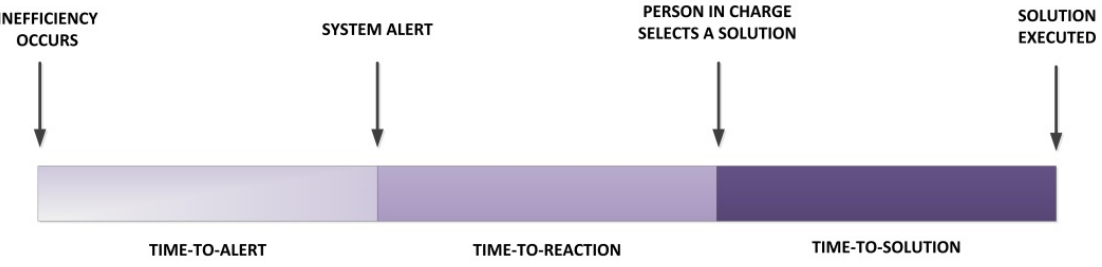
Figure 13. Response time to inefficiencies